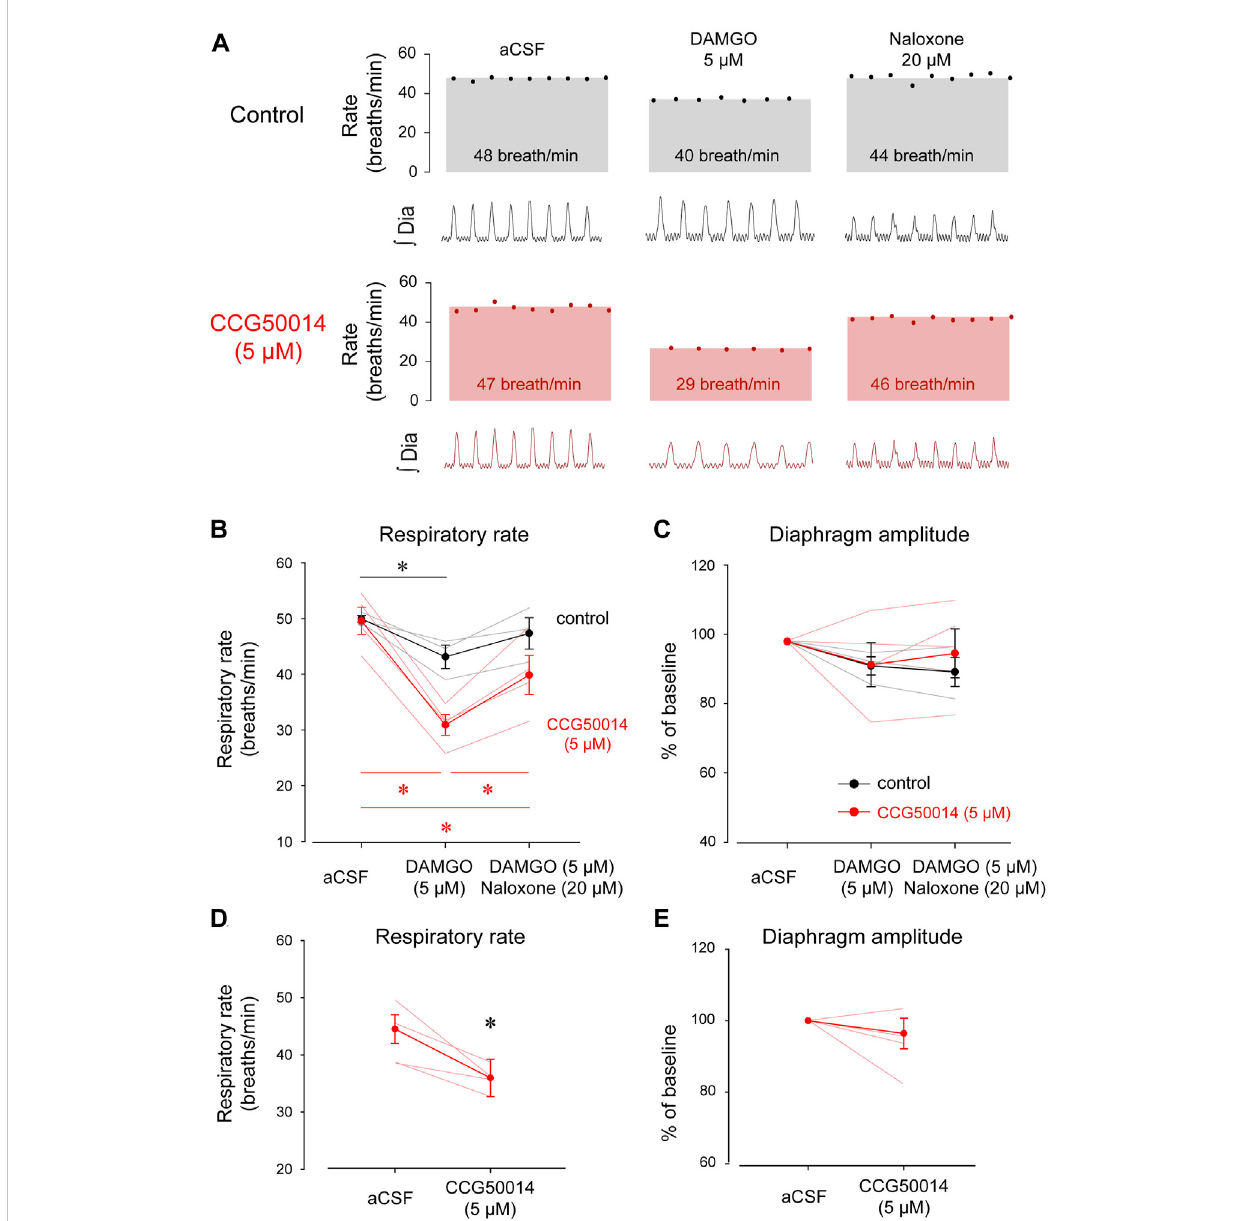
FIGURE 4 Inhibition of RGS4 has limited impact on respiratory rate depression by DAMGO. (A) Inhibition of RGS4 potentiates MOR inhibition by the ligand DAMGO. (B) Pharmacological inhibition of RGS4 by CCG50014 signi fi cantly accentuated respiratory depression by DAMGO perfused in the preBötC compared to DAMGO alone. (C) The combination of DAMGO + CCG50014 (5 µM) induced a stronger respiratory rate depression than DAMGO alone (5 µM). Naloxone partially reversed respiratory rate depression by DAMGO and CCG50014. (D) Diaphragm amplitude was not signi fi cantly reduced by DAMGO with or without CCG50014. To determine whether RGS4 inhibition alone affects respiratory rate, we microperfused CCG50014 to the preBötC.CCG50014(5 µM)decreasedsigni fi cantlyrespiratoryrate (E) butnotdiaphragmamplitude (F) .aCSF,arti fi cialcerebrospinal fl uid.MOR,µ-opioid receptors. RGS, regulators of G-protein-signaling. * indicate means signi fi cantly different. Circles indicate mean values